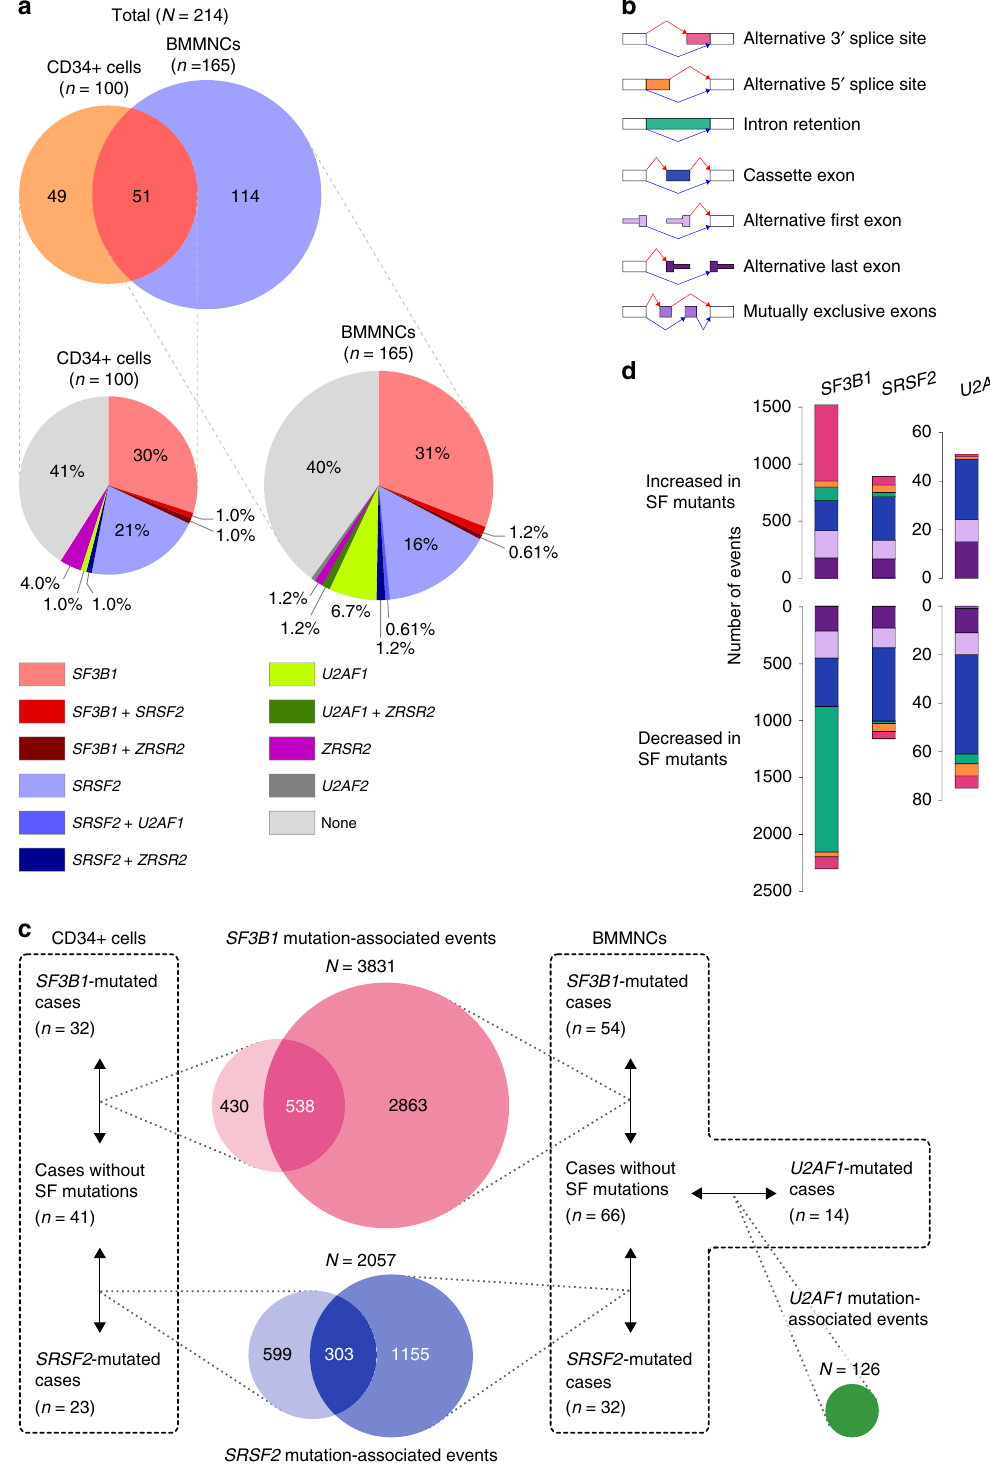
Fig. 1 Overview of a transcriptomic analysis of 265 bone marrow samples. a Sources of RNA and frequencies of SF mutations. A Venn diagram shows sources of RNA. The pie charts below depict frequencies of SF mutations among 165 cases with BMMNCs and 100 cases with CD34 + cells. b Types of alternative splicing events. Cassette exon means inclusion or skipping of an exon. c An overview of differential splicing analysis. Comparison of splice junction usage between SF-mutated and non-mutated samples was performed for each cell fraction. Alternative splicing events associated with each SF mutation with a q -value of <0.01 were regarded as differentially spliced. Venn diagrams show numbers of alternative splicing events signi fi cantly associated with each SF mutation. d Types and numbers of splicing alterations signi fi cantly associated with each SF mutation. Bars in the upper